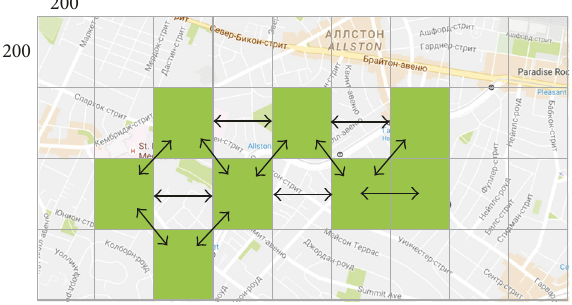
Figure 9: A connected graph constructed from an enlarged